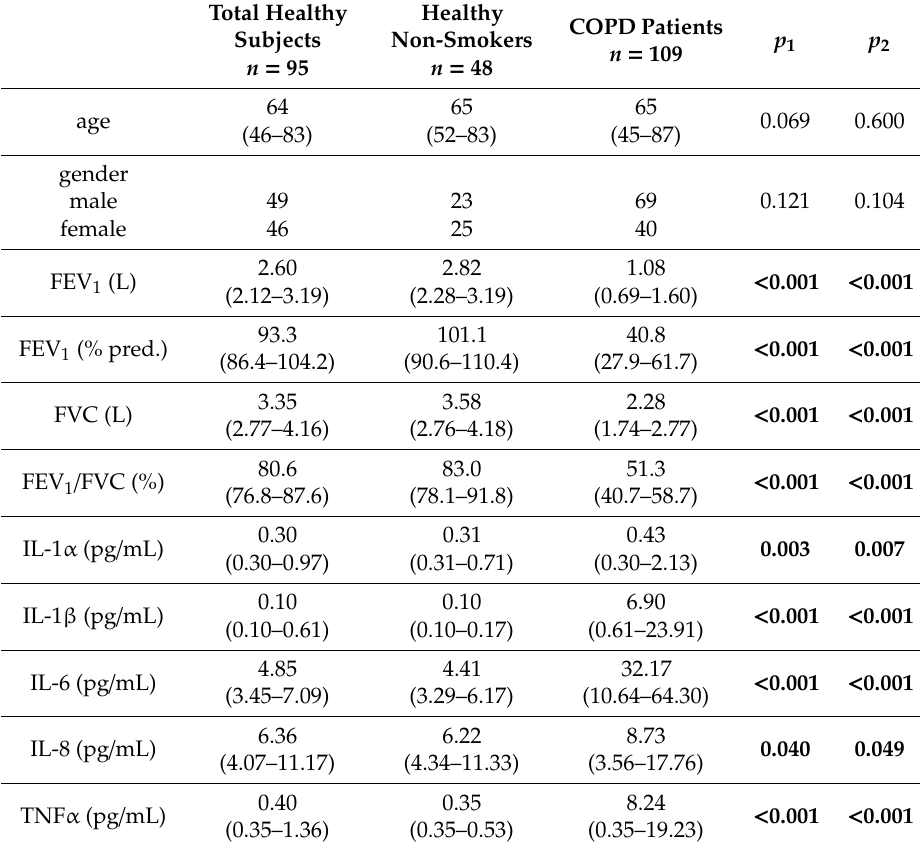
Table 1. Demographic characteristics, spirometry parameters and cytokines’ concentrations in participants from the